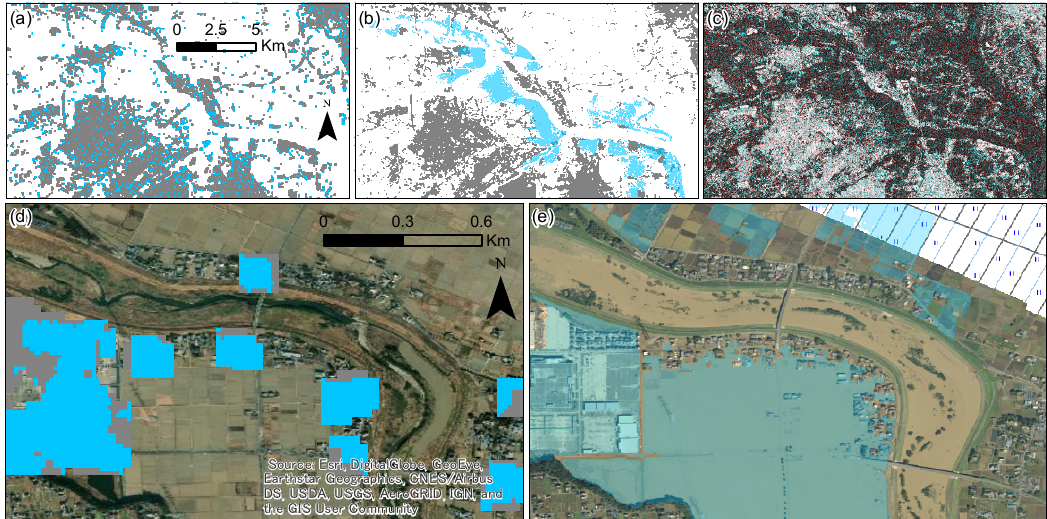
Figure 9. Closer look of the affected area in the city of Nagano, Nagano Prefecture. ( a ) The predicted flood map. ( b ) The reference flood map provided by GSI. ( c ) The RGB coherence color composite. ( d ) low dense rural area, image recorded before the flood. ( e ) Aerial image of the flooded area shown in ( d ). The image is provided by the